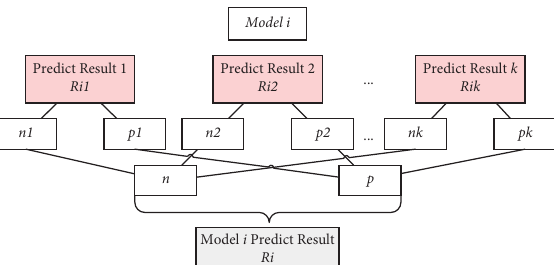
Figure 1: Stacking methods framework.